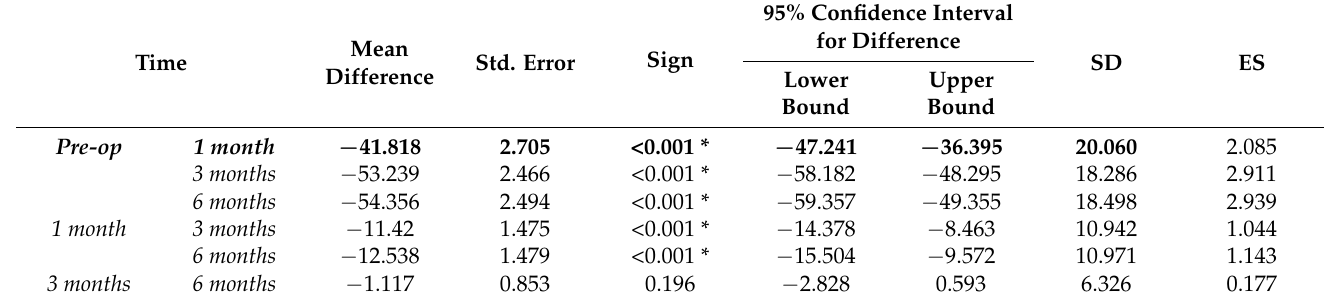
Table 5. Responsiveness of WOMAC over time.